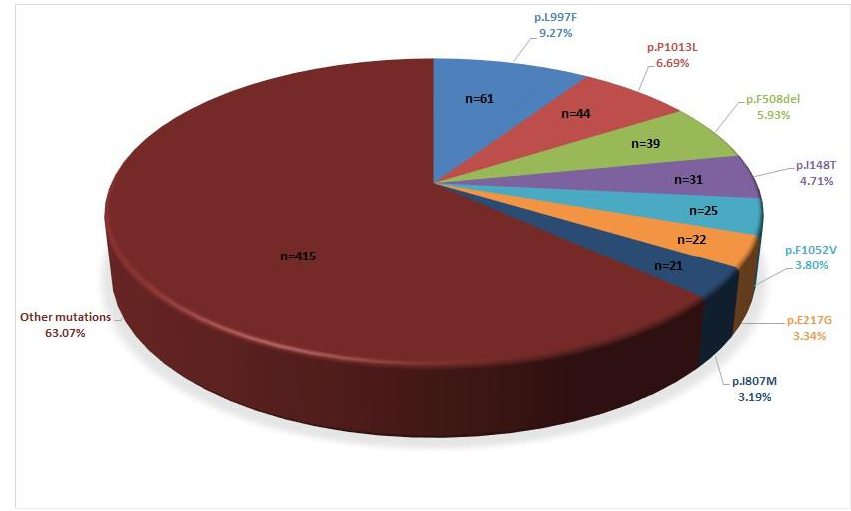
Figure 2. Distribution of the most frequent mutations. The vast majority of the mutant alleles were single base-pair substitutions; 118 of the 160 variants were missense mutations. Twenty-three of the patients had an intronic variant, while nine patients had a nonsense mutation (calculations were made excluding p.V470M; Figure 3).